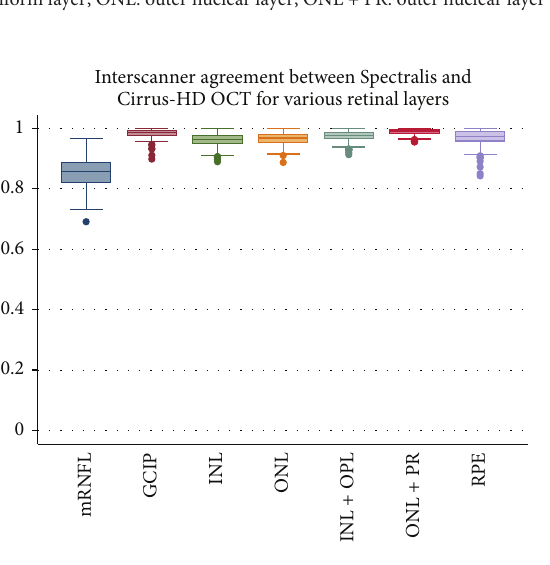
Figure 3: Interscanner agreement indices comparing Spectralis and Cirrus HD-OCT. The graph shows box plots of interscanner agreement indices for individual retinal layers. Except for the macular retinal nerve fiber layer (mRNFL), all other layers show excellent agreement evidenced by values close to